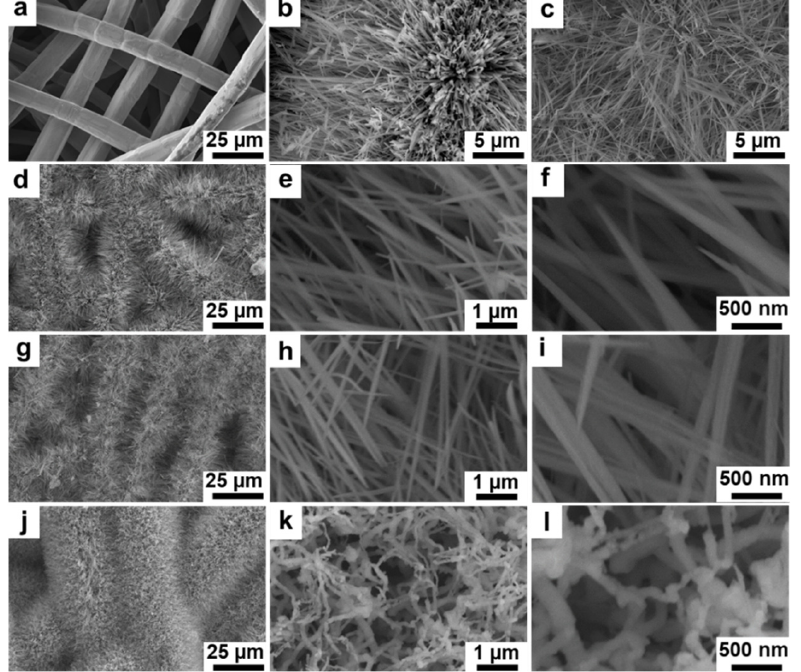
Figure 1. The SEM images of ( a ) the SSF substate; ( b ) the Co(OH) y (CO 3 ) (1 − 0.5y) ·nH 2 O NWs precur- sors; ( c ) the CoO 4 NWs; and the CoS 2 /SSF samples sulfureted at ( d – f ) 300 °C, ( g – i ) 400 °C, and ( j – l ) 500 °C.